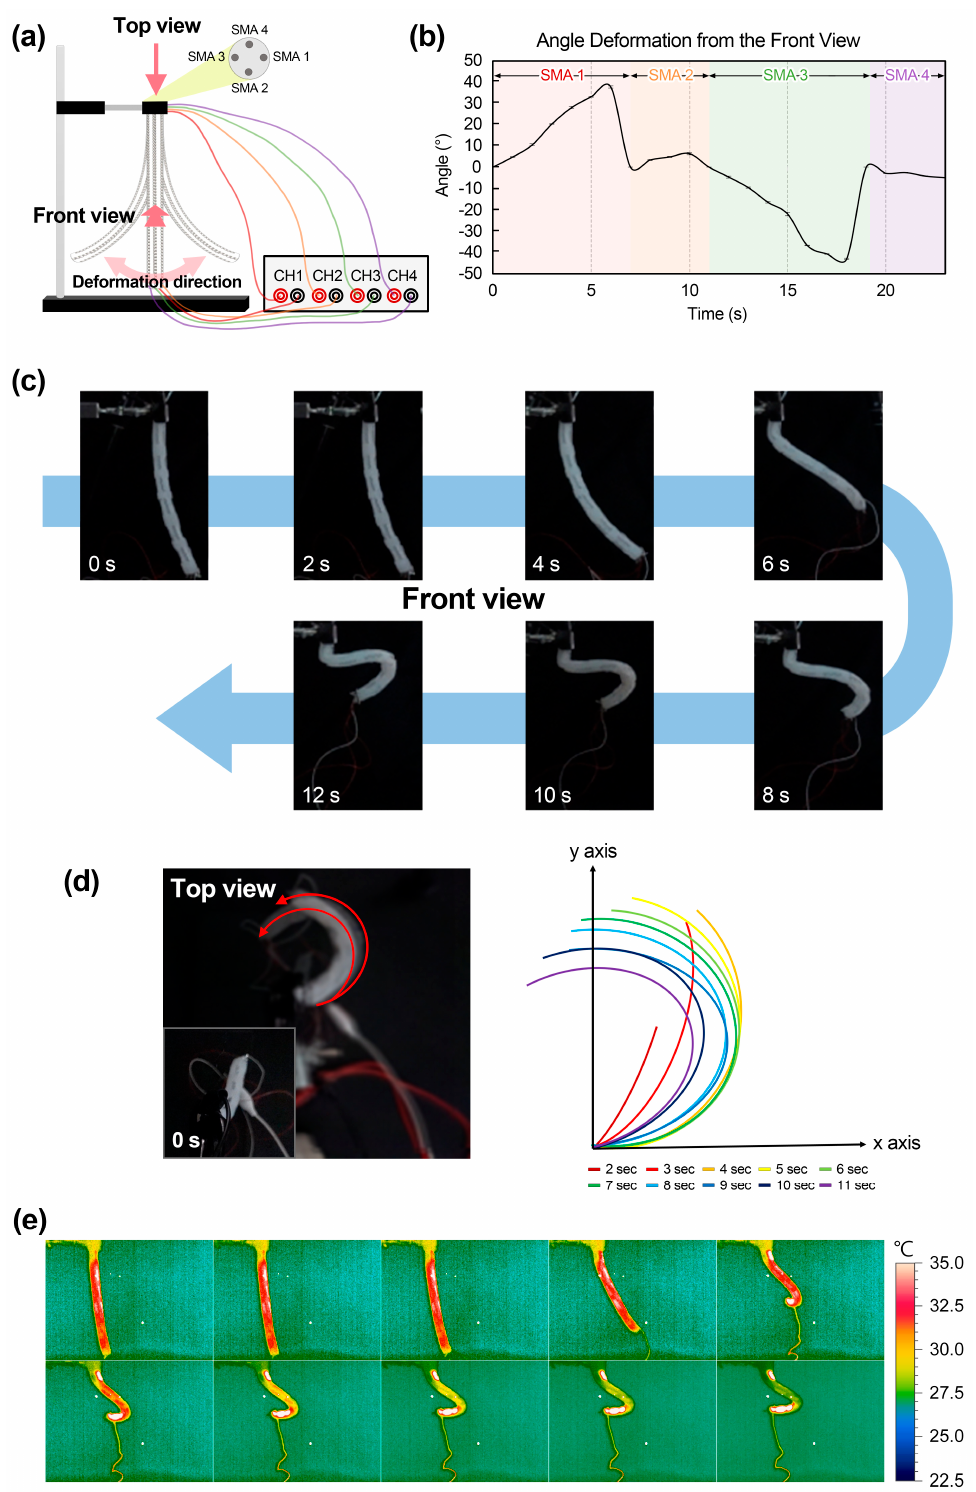
Figure 6. ( a ) Actuation setup for the four-axis elephant trunk actuator. ( b ) Deformation from the front view of the actuator. ( c ) Deformation sequence observed from front view. ( d ) Deformation of the actuator viewed from the top at every two seconds. ( e ) Temperature changes according to current application.